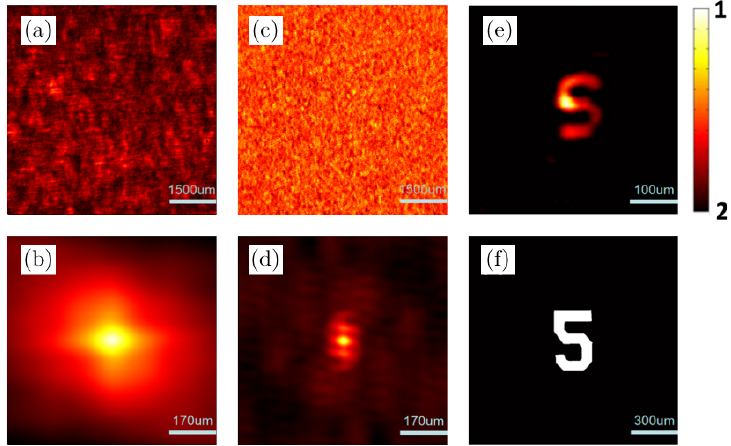
Fig. 4. Experiment result of the ground glass sample. (a) is a captured speckle pattern, signal light is submerged in disturbance, not image can be acquired based on the single pattern. (b) the autocorrelation of (a). (c) The di®erence of two frames (cid:1) I and (d) the corresponding autocorrelation. (e) The reconstructed image with a magni¯cation M ¼ v = u ¼ 0 : 35. (f) A photograph of the